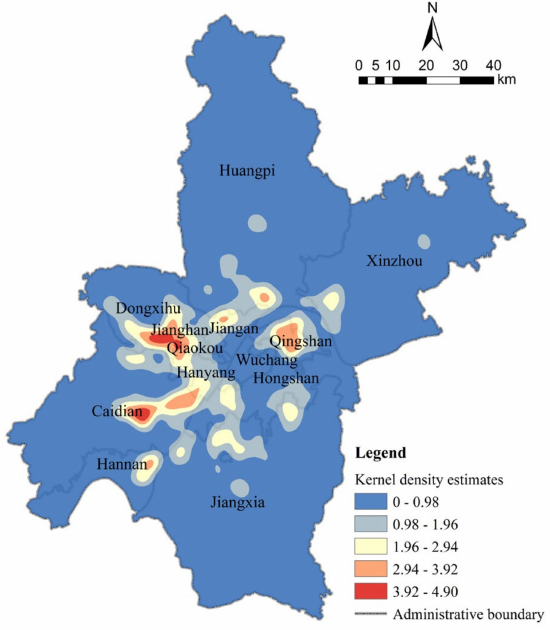
Figure 5. Kernel density analysis results of the freight demand in